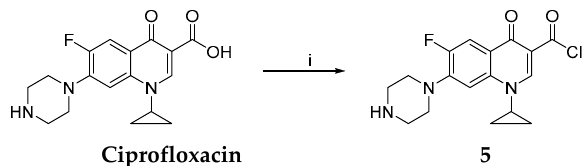
Scheme 4. Synthesis of chlorinated ciprofloxacin 5. Reagents and conditions: (i) SOCl 2, RT, 2 h.